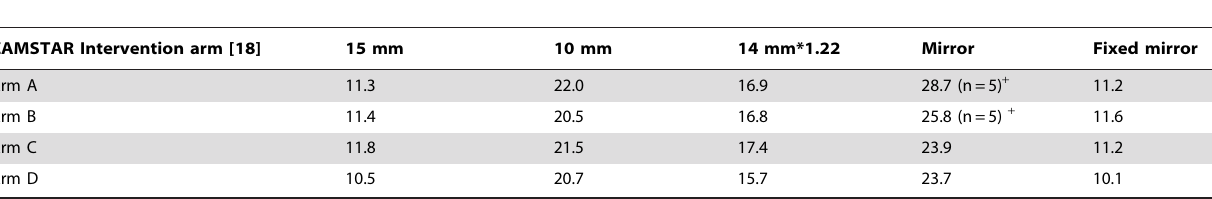
Table 4. Average tuberculous infection prevalence estimates by intervention arm based on estimated prevalence calculated by various published